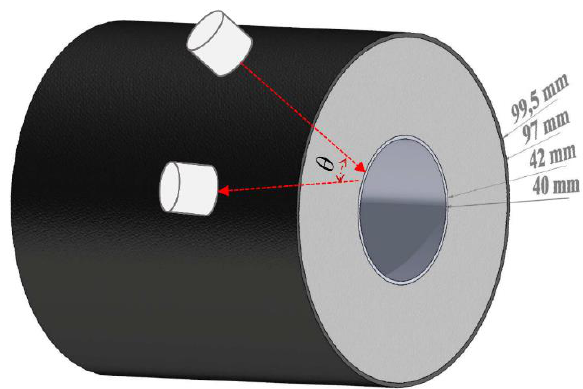
Figure 11. Schematic diagram of the industrial pipe illustrating transducer placement.